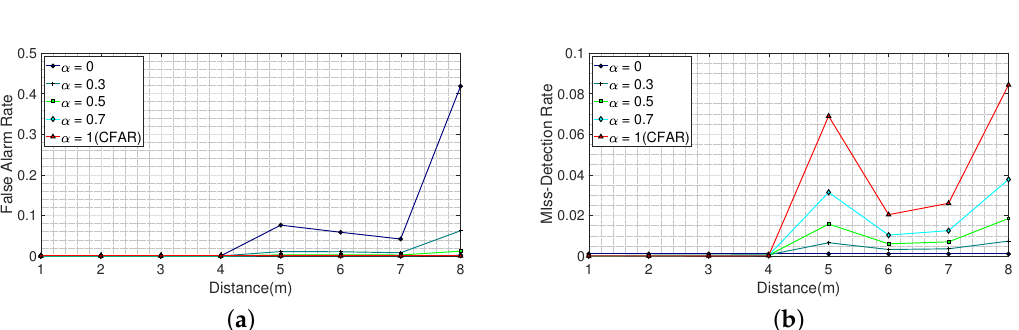
Figure 17. The false alarm rate and miss-detection rate in a light clutter environment according to α . ( a ) False alarm rate according to α . ( b ) Miss-detection rate according to α .